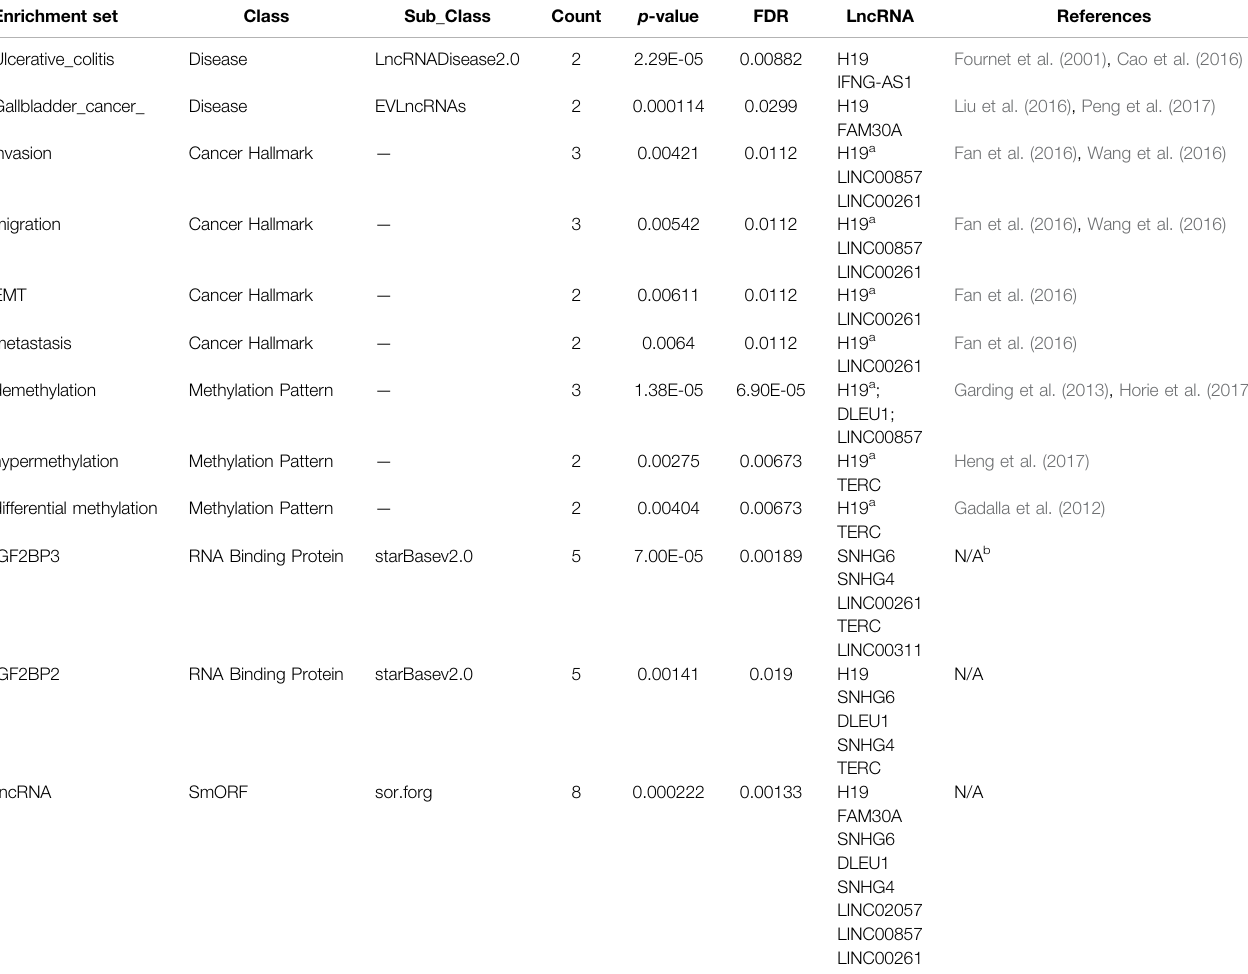
TABLE 3 | Enrichment analysis of differentially expressed lncRNAs through